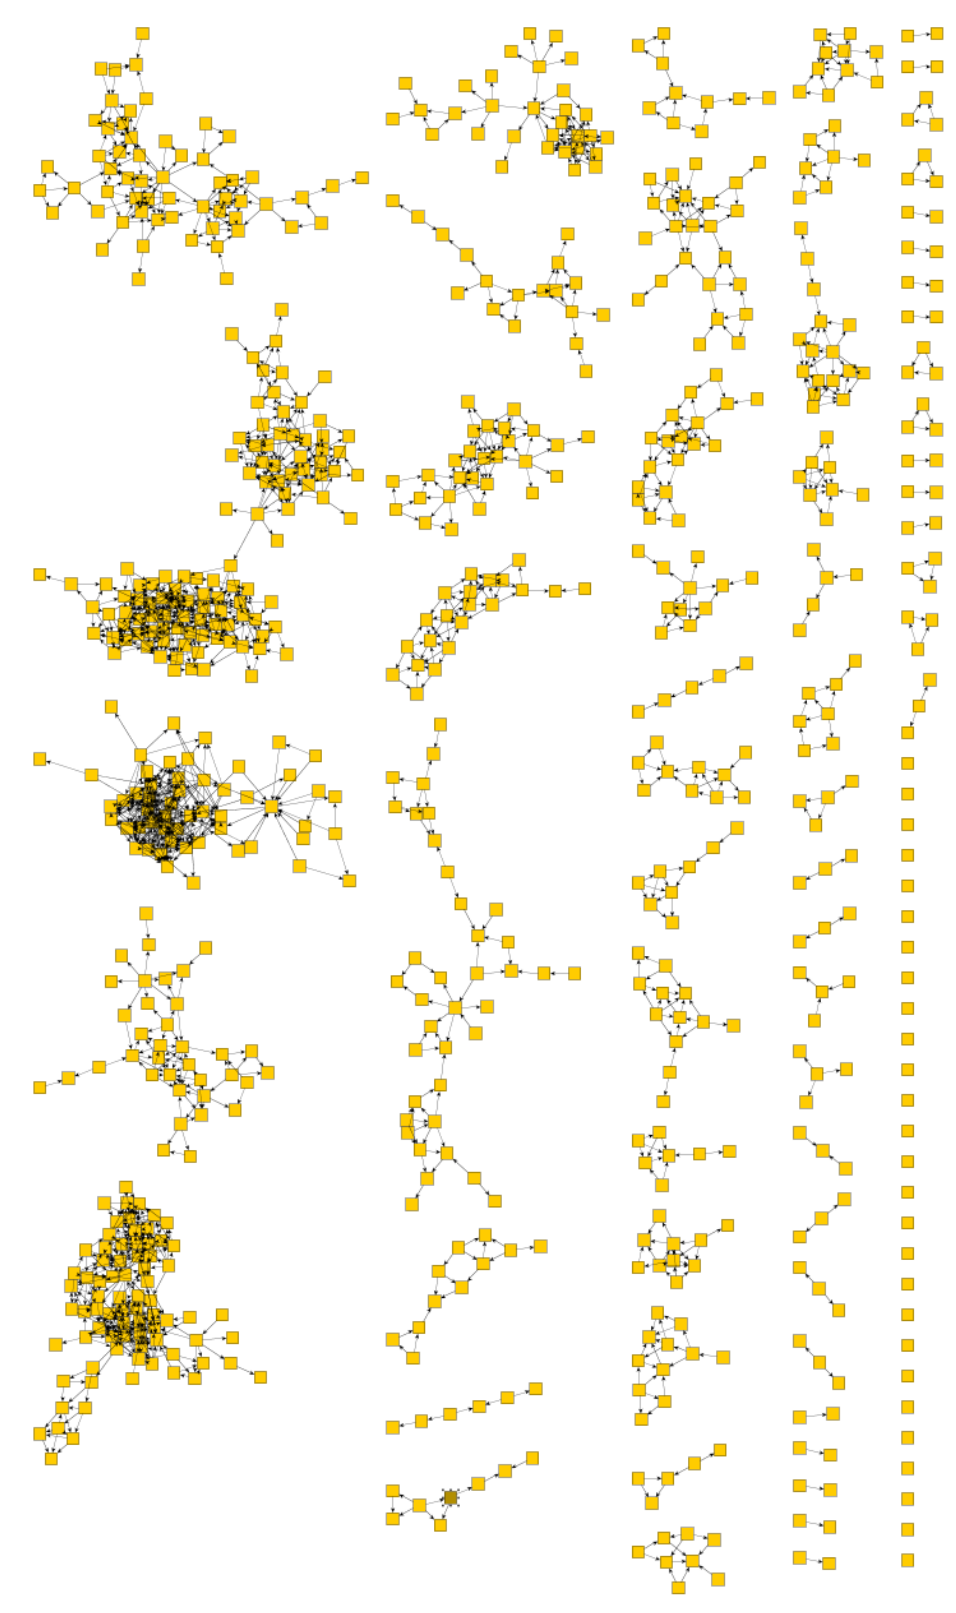
Figure 2: Consistency graph for around 1000 triangular 2D traffic signs detections. Nodes are 2D detections of 3D signs, and an edge exists if the detections corresponding ton the connected nodes are compatible (cf Section 2.2). Large components indicate very ambiguous clustering situations. Our method aims at partitioning the connected components in a minimum number of cliques of minimum